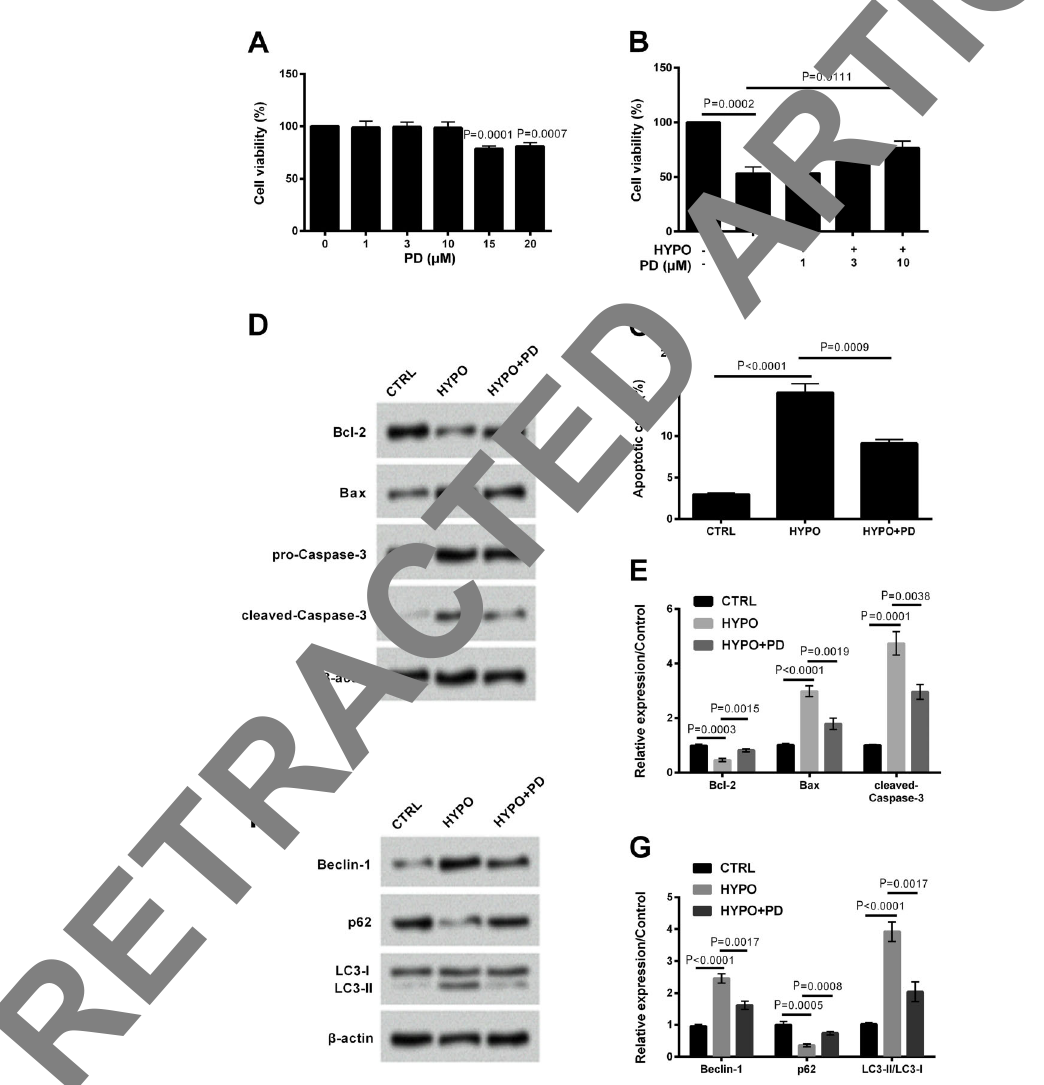
Figure 2. Polydatin (PD) reduced hypoxic injury of H9c2 cells. A , H9c2 cells were treated with PD at the concentrations of 1, 3, 10, 15, and 20 m M. B , H9c2 cells were pretreated by PD before hypoxia (HYPO). Cell viability was detected by CCK-8 assay. C , Cell apoptosis was assessed by fl ow cytometry. D and E , Western blot was used to measure the expression levels of Bcl-2, Bax, pro-caspase-3, and cleaved-caspase-3. F and G , Western blot was used to determine the expression levels of Beclin-1, p62, LC-3-II, and LC-I. Data are reported as mean ± SD (ANOVA or Student ’ s t